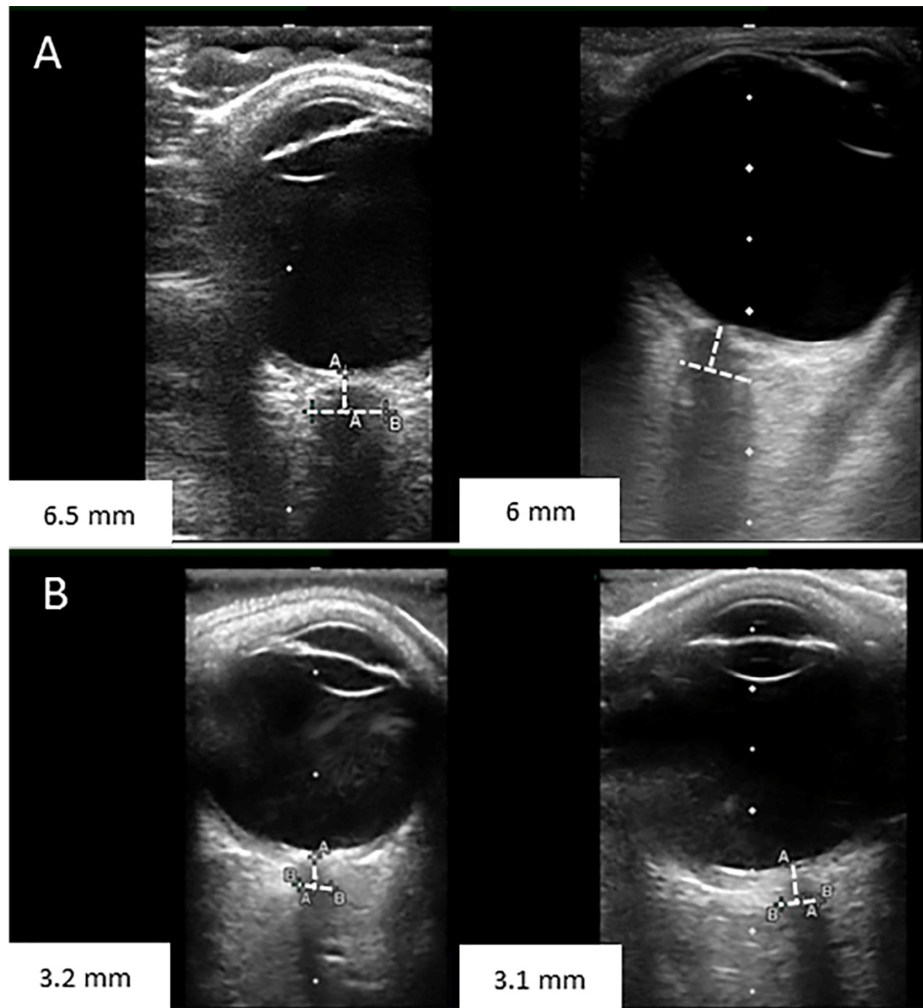
Figure 1. ( A ) Optic nerve sheath diameter measurements pre lumbar puncture were 6.5 and 6 mm. ( B ) Optic nerve sheath diameter measurements post lumbar puncture were 3.2 and 3.1 mm . He was intubated for airway protection. Lumbar puncture was performed with an opening pressure of 44 cmH 2 O. After removing 80 mL of cerebrospinal fluid, the closing pressure was 15 cmH 2 O. ONSD was measured again, obtaining a diameter of 3.2 and 3.1 mm for the right and left optic nerves, respectively. He was treated with high-dose methylprednisolone, hyperosmolar therapy, and sedation for grade 4 ICANS. An external ventricular drain (EVD) was placed for monitoring (first measure after placement was 3 cmH 2 O). A brain MRI showed increased T2-hyperintensity in the thalami and dorsal pons (Figure 2).